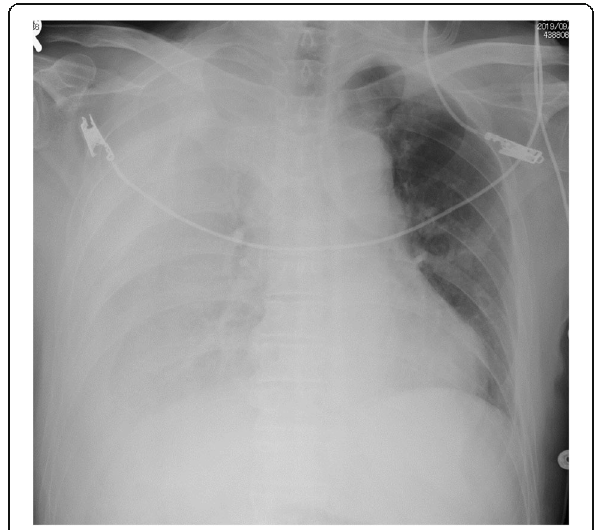
Fig. 1 Chest X-ray showing decreased permeability of the right lung field